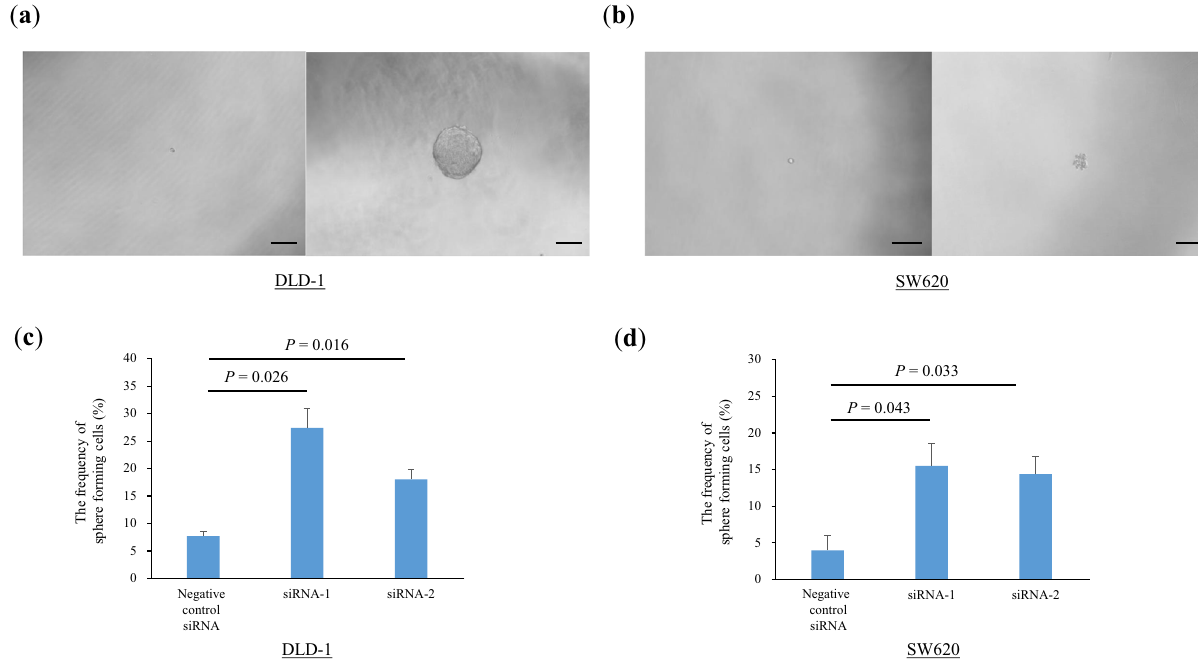
Figure 5. Sphere formation assay in colorectal cancer cells. ( a , b ) Representative pictures of sphere formation in DLD-1 ( a ) and SW620 ( b ) cells treated with siControl and siSmurf2. ( c , d ) The sphere formation rate were evaluated in DLD-1 ( c ) and SW620 ( d ) cells treated with siControl and